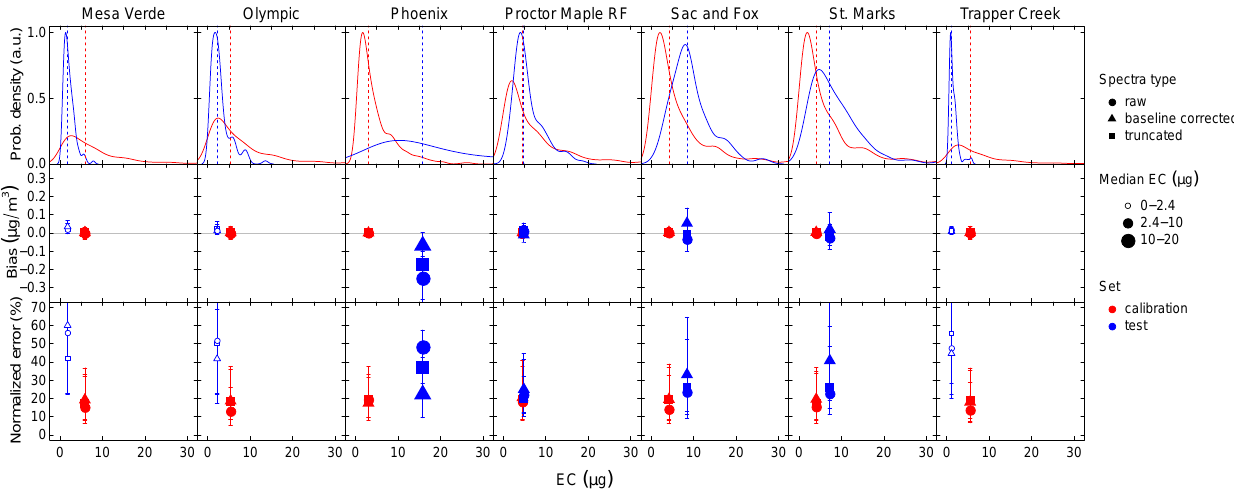
Figure 6. The distribution of EC and bias and normalized error (with the interquartile range shown by error bars) in the calibration (red) and test (blue) sets for calibrations developed for each site. Vertical lines are the median of the EC mass distributions color-coded for calibration and test sets.